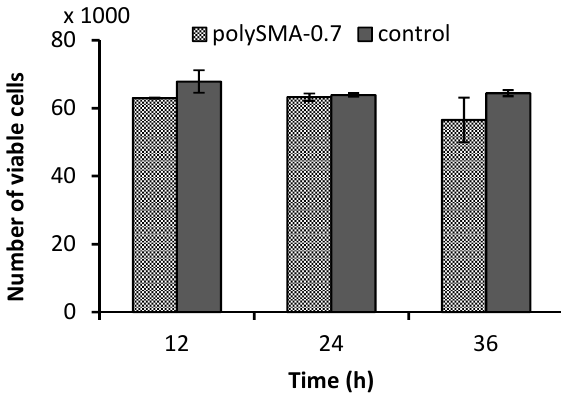
Figure 5. Number of viable human fibroblast cells after various time of their growth on polySMA-0.7 hydrogel determined by AlamarBlue assay. Error bars were calculated using the standard deviation ( n = 3).